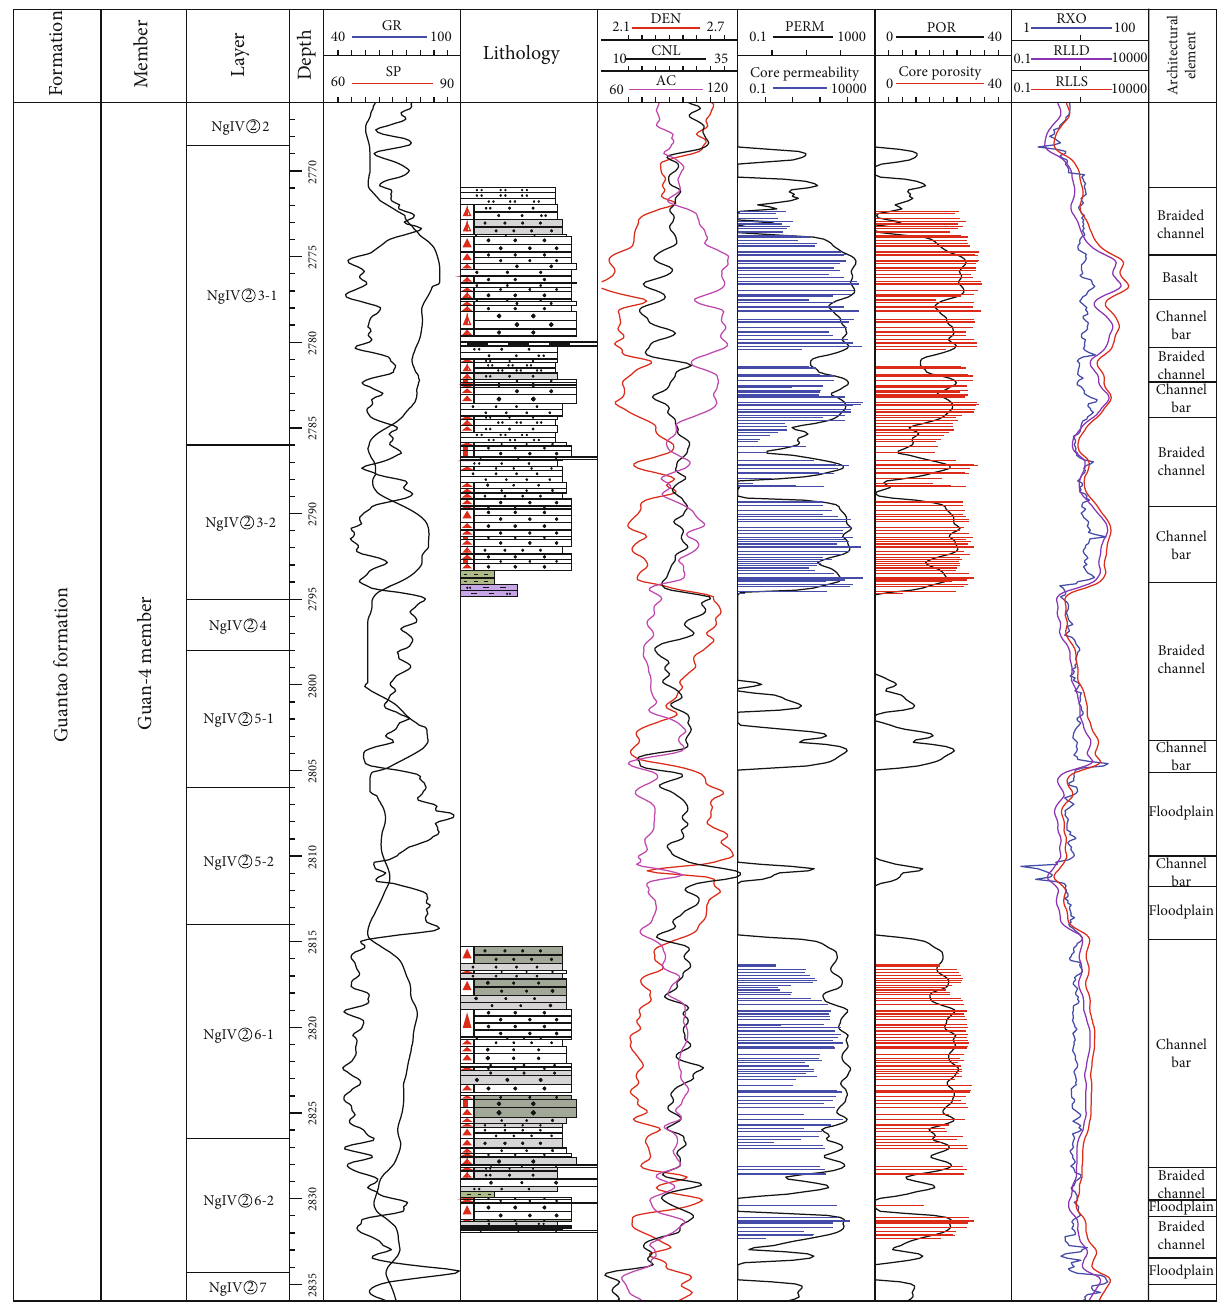
Figure 3: Comprehensive histogram of well NP12-X77 in Nanpu 1-29